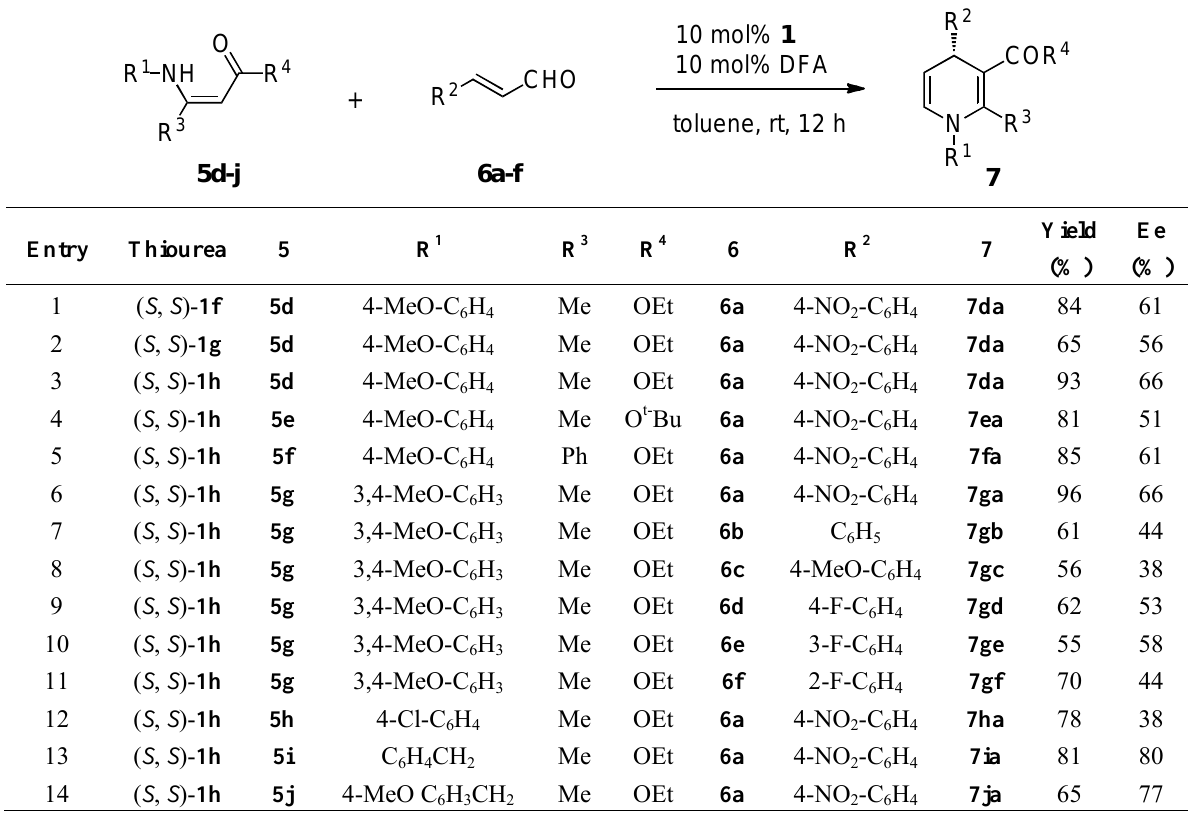
Table 4. Scope of the substrates 5 and 6 for the synthesis of 2,3,4,-trisubstituted 1,4-DHP's.